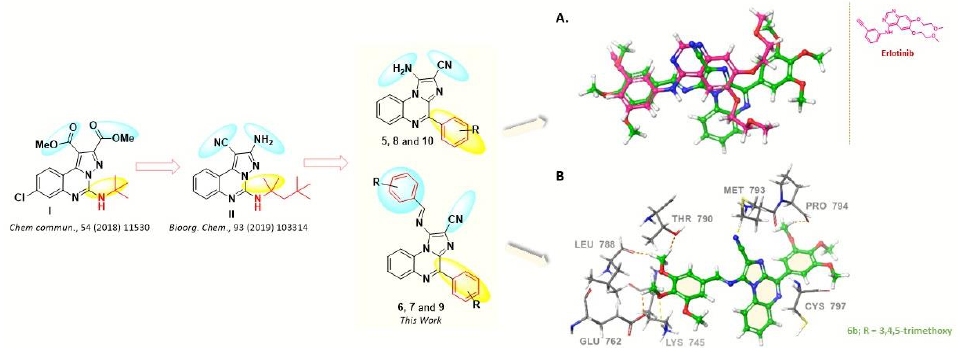
Figure 2. Design of target compounds ( 5 – 10 ): ( A ) Docked 3D-poses and overlay of designed compound (e.g., 6b; R = 3,4,5- trimethoxy- a representative compound) and erlotinib showing similar binding modes at ATP binding domain of EGFR WT (PDB: 3VJO); ( B ) 3D-interaction diagram of the designed compound with ATP binding pocket of EGFR WT (PDB: 3VJO).